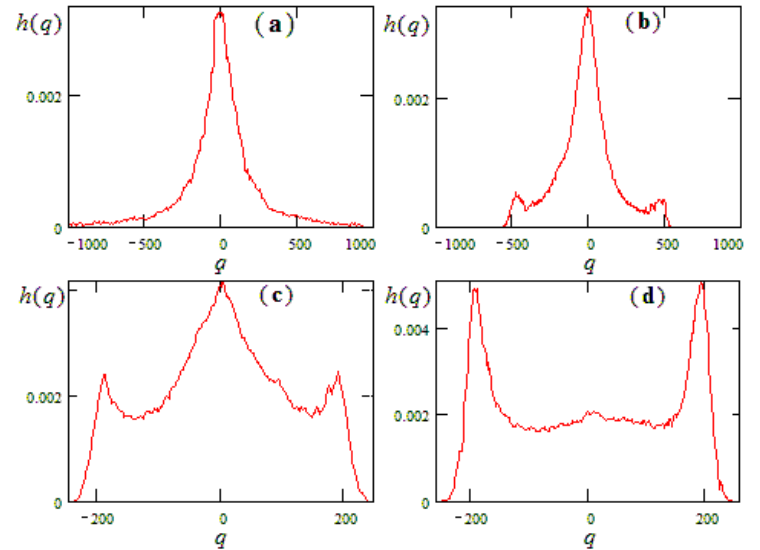
Figure 11: The distribution of the order parameter h ( q ) for the Gillespie stochastic simulation as a function of the degradation constant in the monomer case: (a) k δ = 0 . 1 ; (b) k δ = 0 . 25 ; (c) k δ = 0 . 5 ; (d) k δ = 1